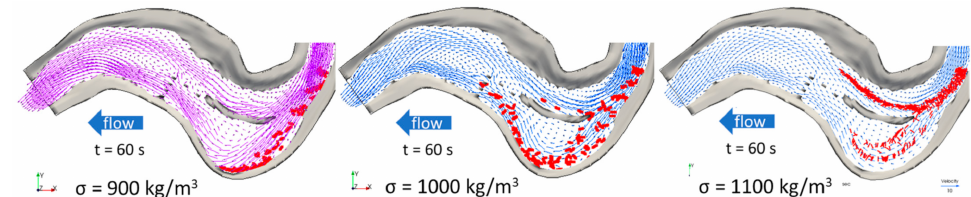
Figure 17. Simulated driftwood distributions with different specific gravities (0.9 (( Left ) Run 8), 1.0 (( Middle ) Run 7), and 1.1 (( Right ) Run 1)) at t = 60 s. The velocity vectors at the bottom (for specific gravities of 1.0 and 1.1) and at the surface (specific gravity of 0.9) are shown together.